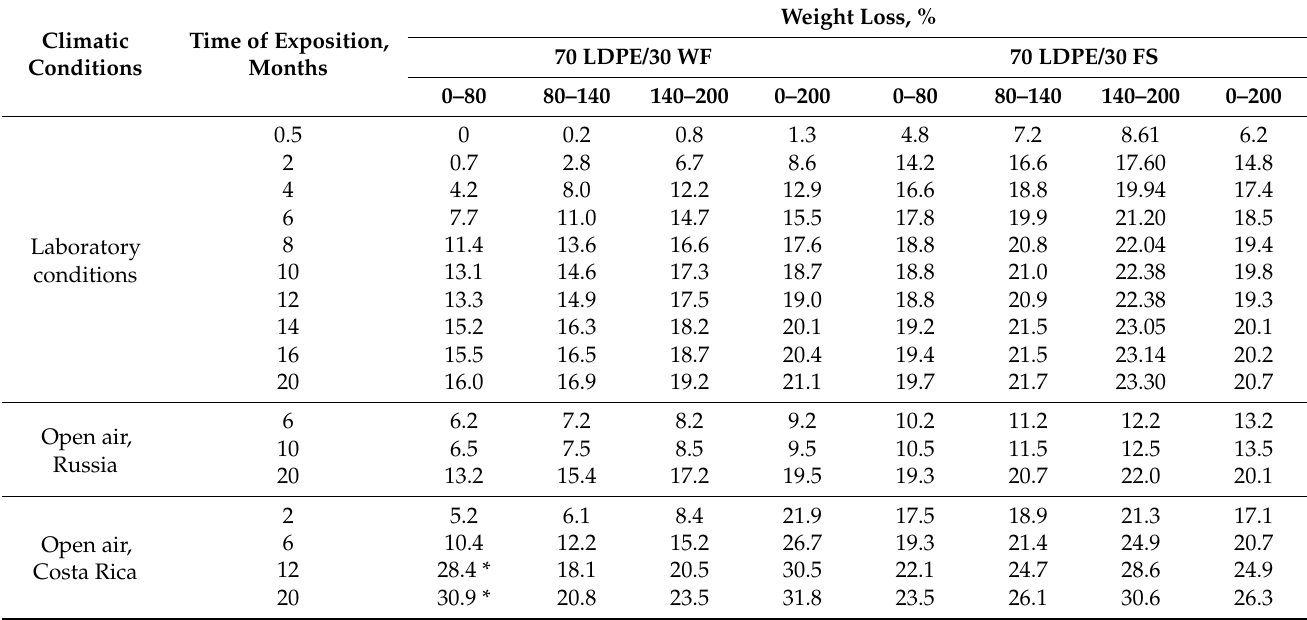
Table 2. Weight loss of biocomposites in different climatic